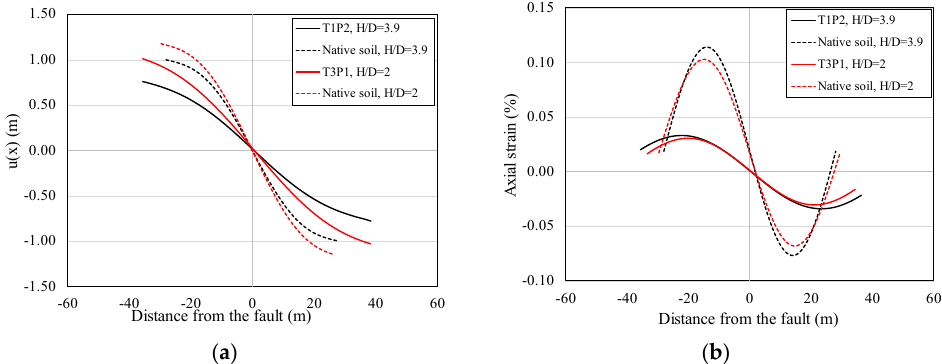
Figure 5. Comparison between the developed analytical model for the trenched pipeline and the analytical model for uniform seabed soil, T1P2 and T3P1 ( β = 0°): ( a ) deformed pipeline shape, ( b ) distribution of axial strains along the pipeline.